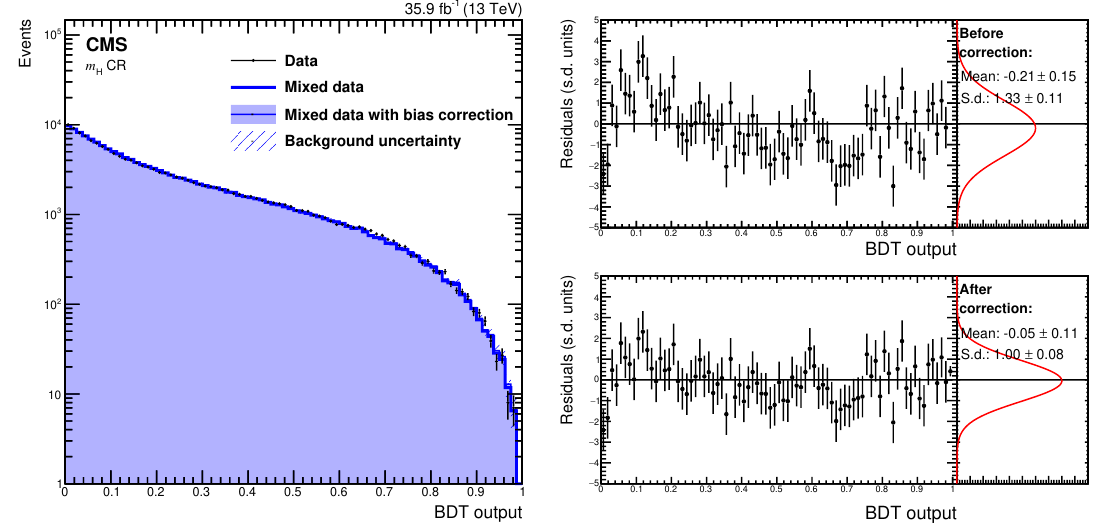
Figure 6 . Left: comparison of the distribution of BDT output for data (left) selected in a region of the leading versus trailing Higgs boson candidate mass plane that excludes a 60- GeV-wide box around the most probable values of the dijet masses of signal events, with the corresponding output on an arti(cid:12)cial sample obtained from the same data set by hemisphere mixing. Right: bin-by-bin di(cid:11)erences between data and model, in s.d. units before (upper right) and after (lower right) bias correction; pull distribution for the di(cid:11)erences, (cid:12)t to a Gaussian distribution. The bias correction uncertainty is increased to take the s.d. of the residuals to